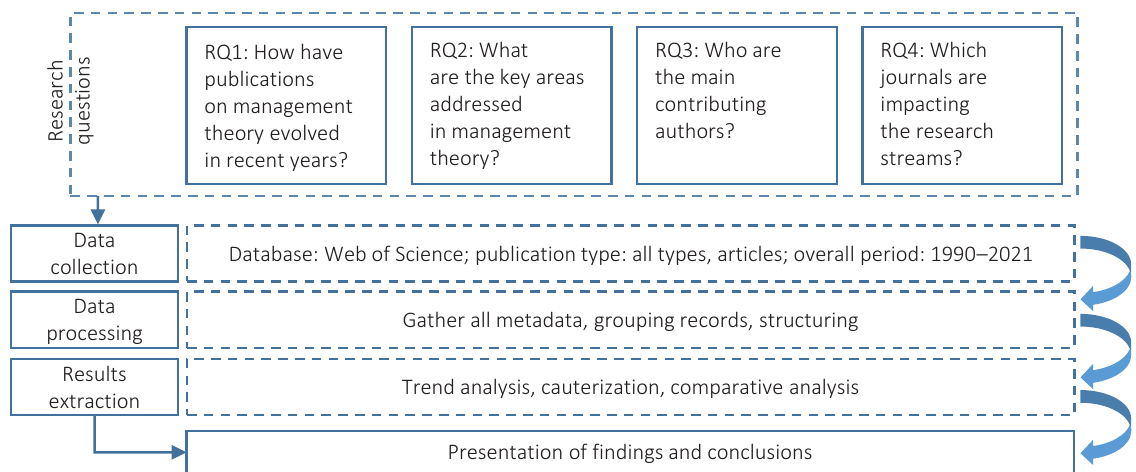
Figure 3. Research